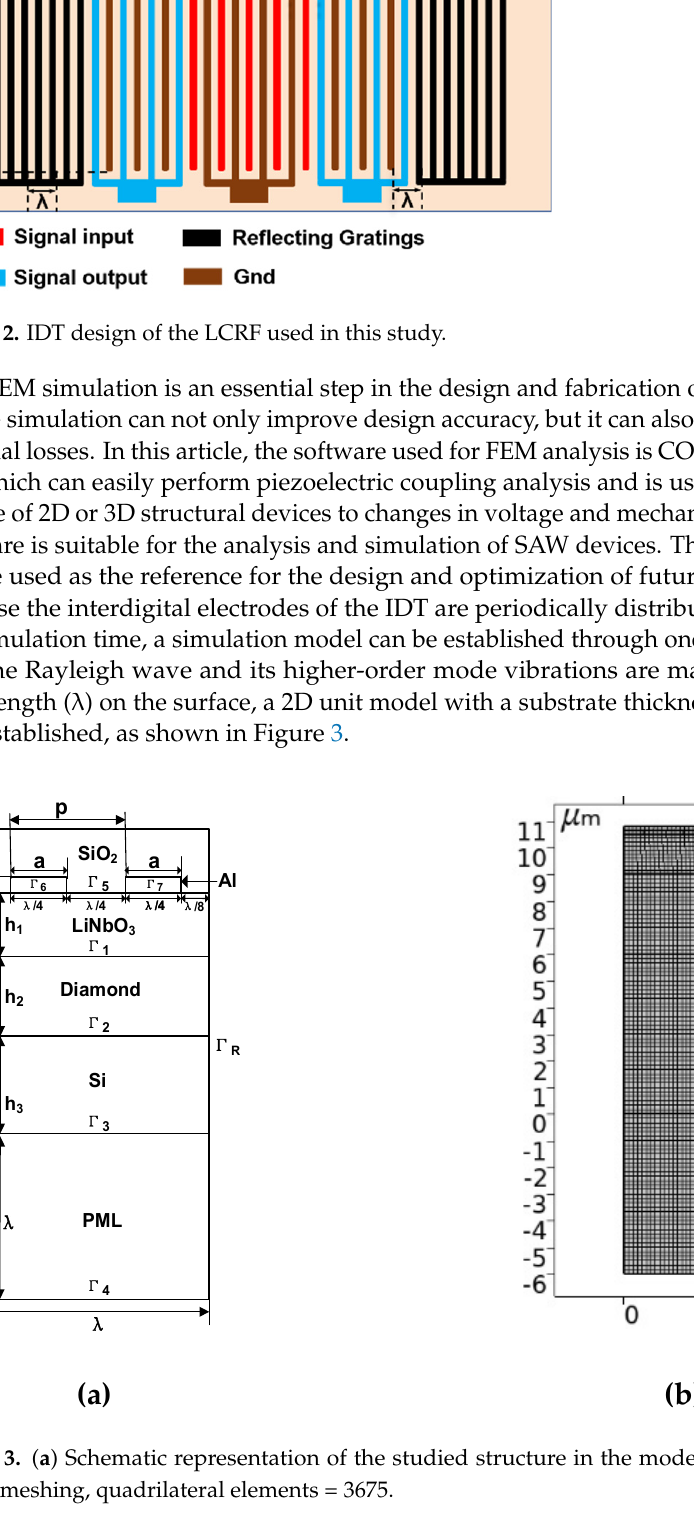
Figure 1. Schematic representation of the SiO 2 /IDT/LiNbO 3 /diamond/Si multilayer structure.